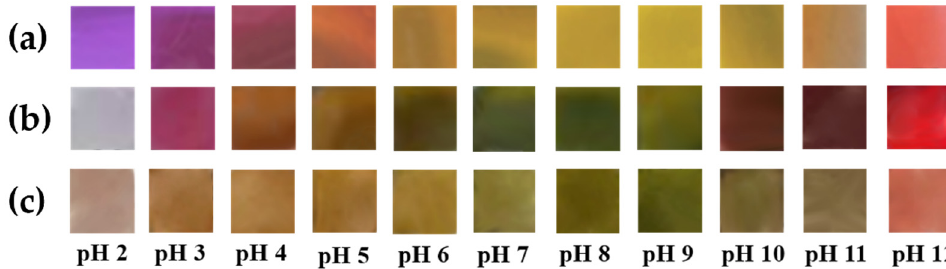
Figure 7. Bio-based-dye-containing polymeric films’ colors at different pH values: ( a ) chitosan–PVA–dye film, ( b ) chitosan–starch–dye film, and ( c ) chitosan–cellulose–dye film.